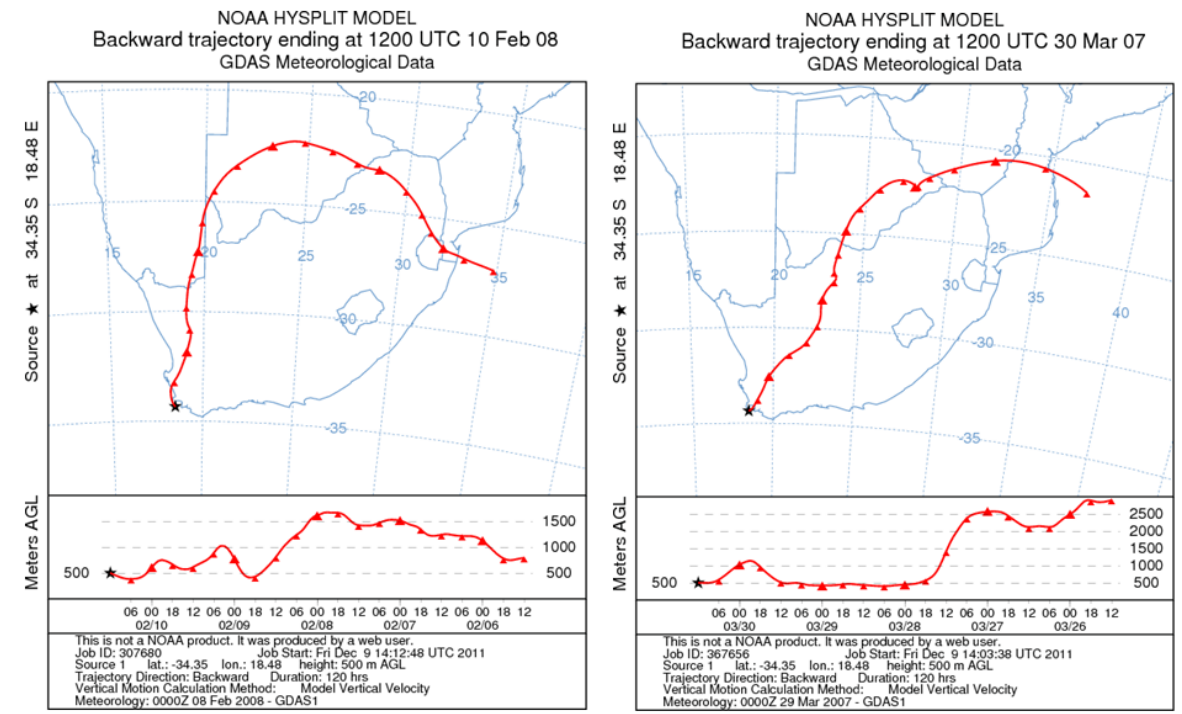
Fig. 4. Backward trajectory for 12:00 of 10 February 2008 (left panel), and 12:00 of 30 March 2007 (right panel). The GEM/ 222 Rn flux Fig. 4: Backward trajectory for 12:00 of February 10, 2008 (left panel), and 12:00 of ratio was + 0.077 ± 0.008pgmBq − 1 for the event on 10 February 2008, and − 0.026 ± 0.005pgmBq − 1 for the event on 30 March March 30, 2007 (right panel). The GEM/ 222 Rn flux ratio was +0.077 ± 0.008 pg mBq -1 for the event on February 10, 2008, and -0.026 ± 0.005 pg mBq -1 for the event on March 30, 2007.